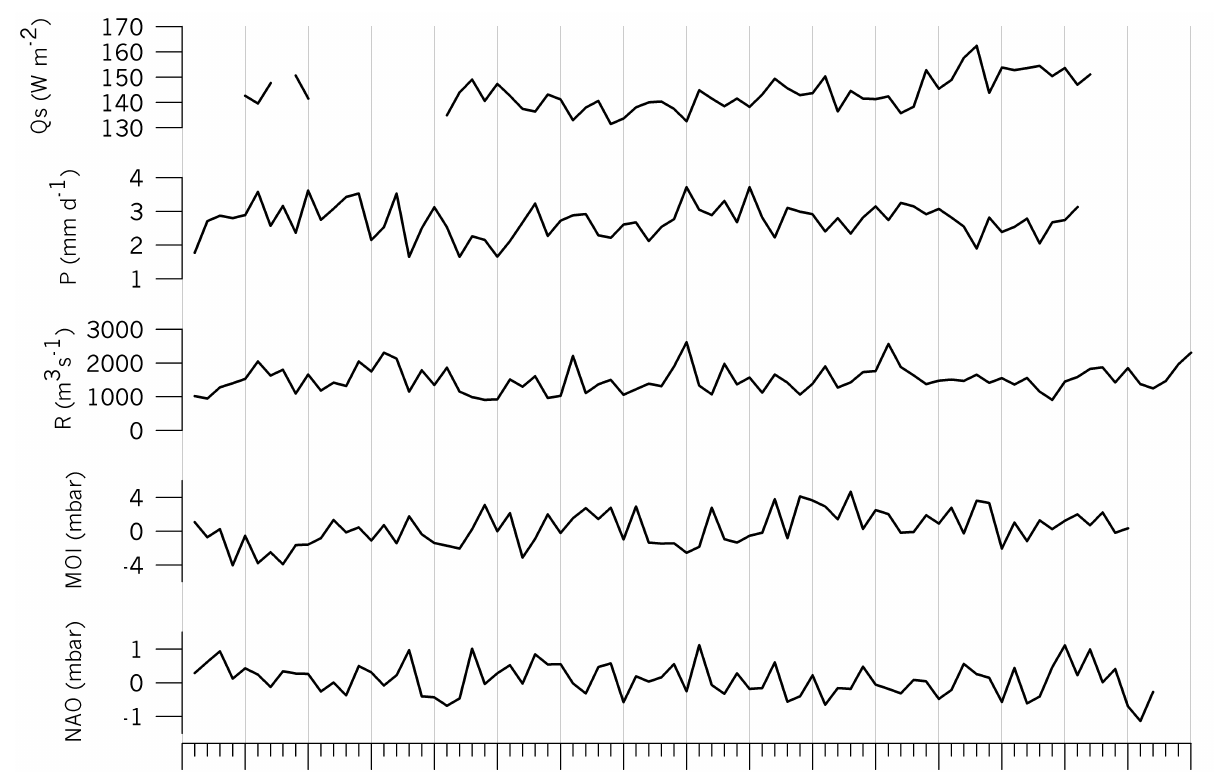
Fig. 5. Yearly means Qs, P, R, the MO and NAO indexes for the 1921–2000 interval.